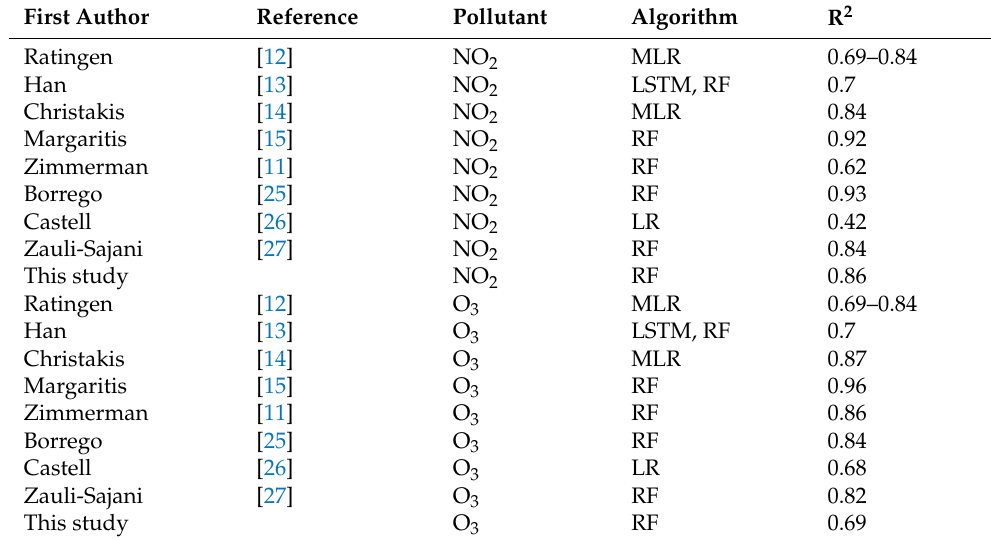
Table 7. Summary of recent studies evaluating the performance of sensor correction algorithms.